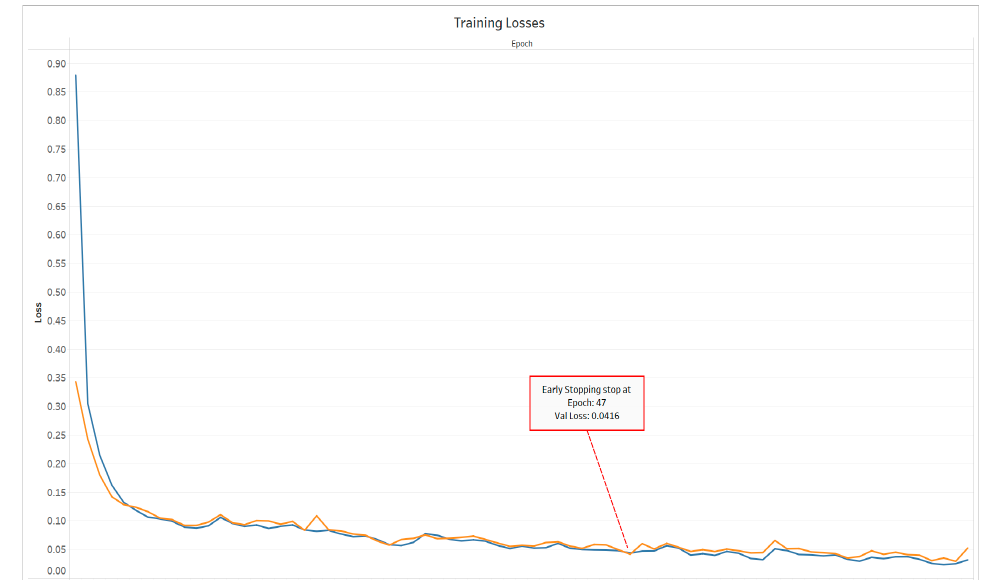
Figure 34. Training accuracy curve.